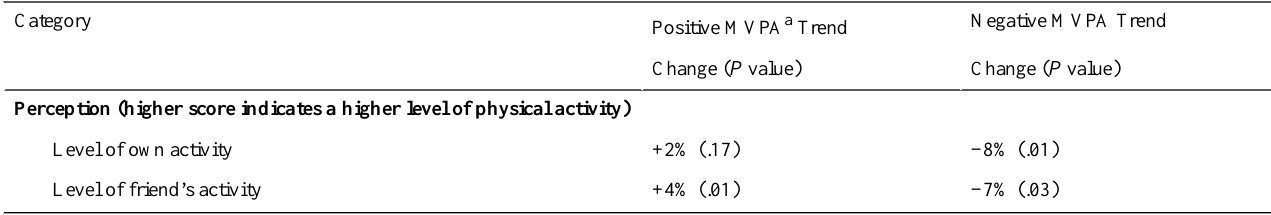
Table 4. Summary of descriptive statistics related to perceptions of participants’ own activity and their friend’s activity based on survey responses. Change refers to the percent difference between the average score for the first and last survey administered.